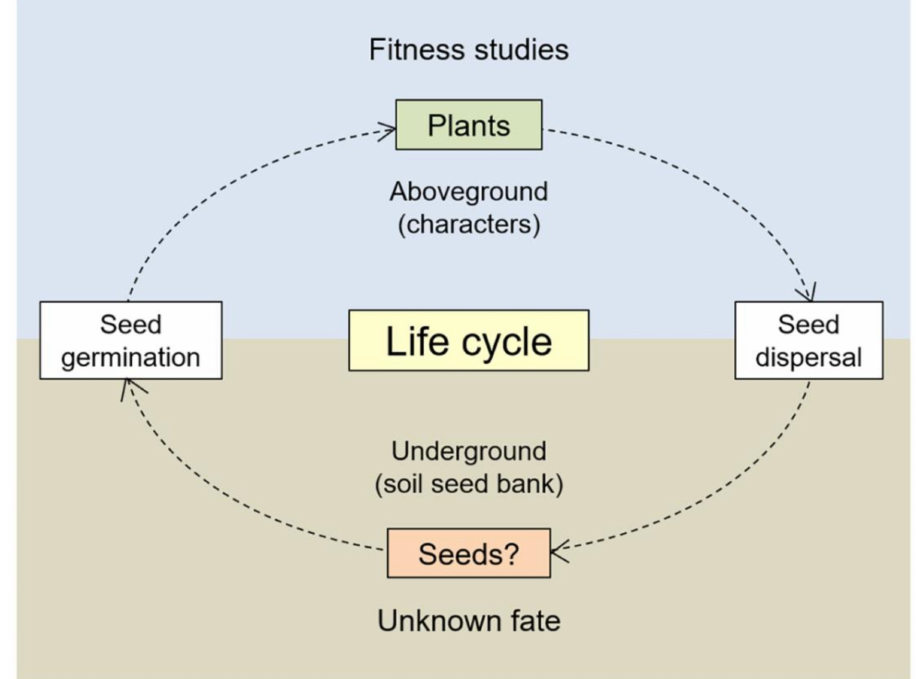
Figure 1. A schematic illustration showing a seed-to-seed life cycle of higher plants. A germinated seed develops into a mature plant that produces next-generation seeds dispersed in the soil seed banks. Studies for transgenic fitness focus essentially on the aboveground characteristics. However, the potential environmental impact of transgenic seeds remaining in the soil seed banks, which determines the overall fitness of plant populations, is almost